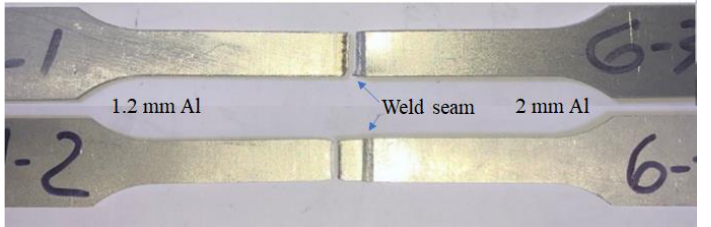
Figure 7. Examples of welded samples fractured in the welded joints (top sample) and the 1.2 mm thick aluminum sheet (bottom sample).